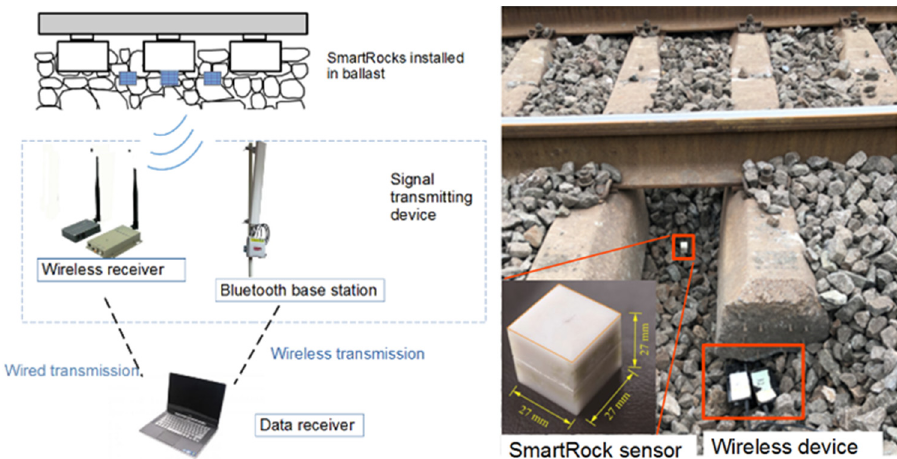
Figure 4. Illustration of the SmartRock (SR) sensing system ( left ) used in railroad track applica- tions ( right ).